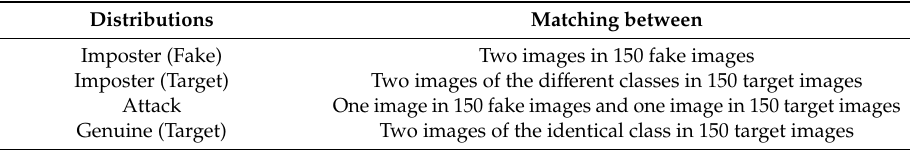
Table 4. Four distance distributions.